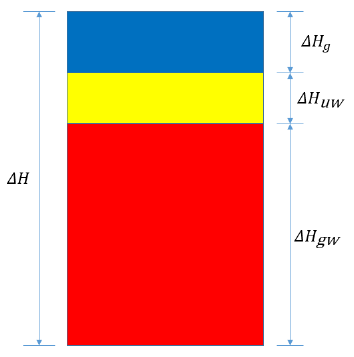
Figure 2. Sketch of factors affecting water level variations of Nam Co Lake.